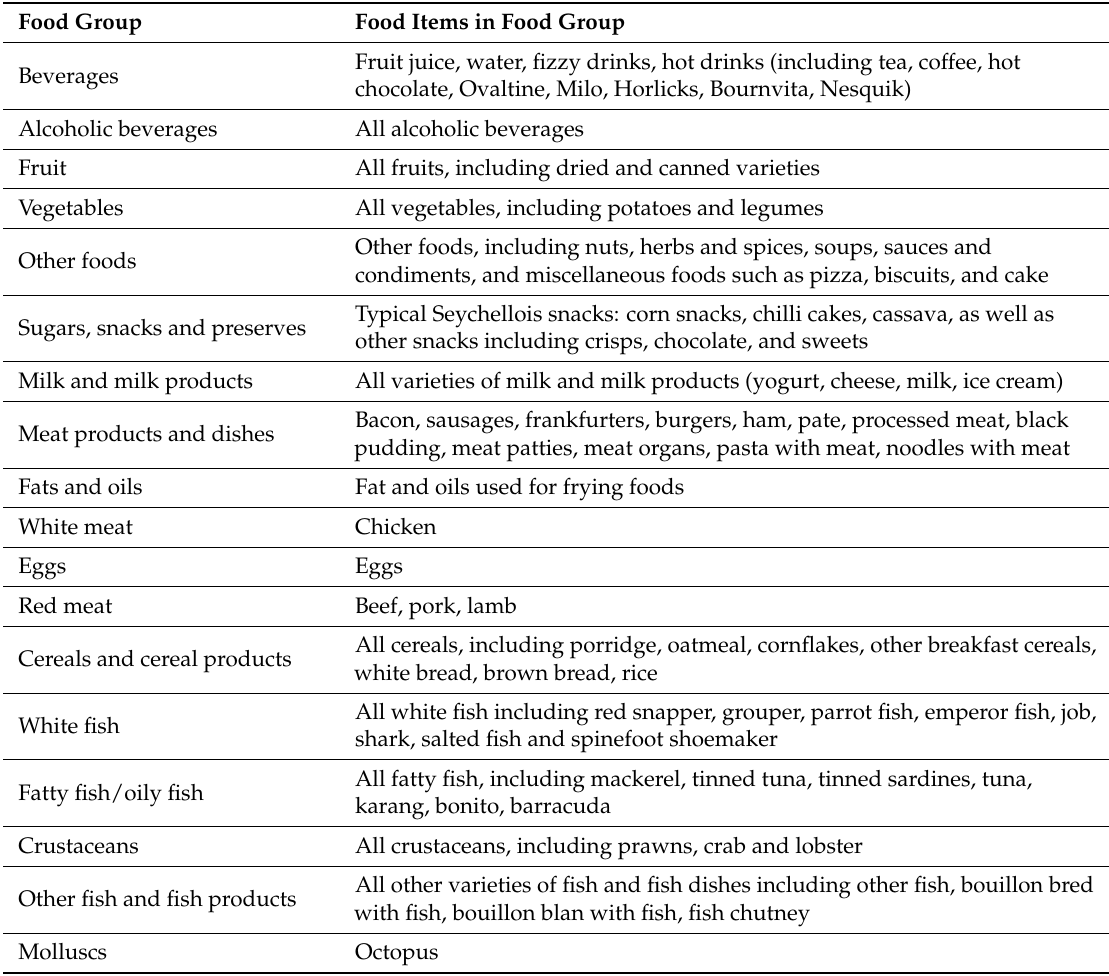
Table 1. Food groups used for dietary pattern